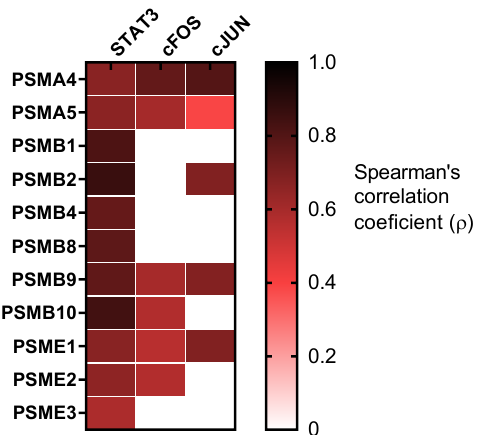
Figure 5. Proteasome subunits relationship with STAT3 pathway genes. Graph represents Spearman’s correlation coefficient ( ρ ) between proteasome subunits mRNA expression and STAT3, cFOS and cJUN. White gaps represent non-significant correlations, while the rest of correlations are significant ( p < 0.05).